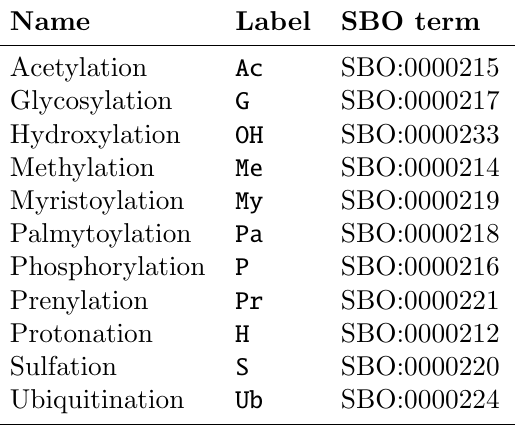
Table 2.3: A sample of values from the covalent modifications vocabulary (Section 2.4.3).